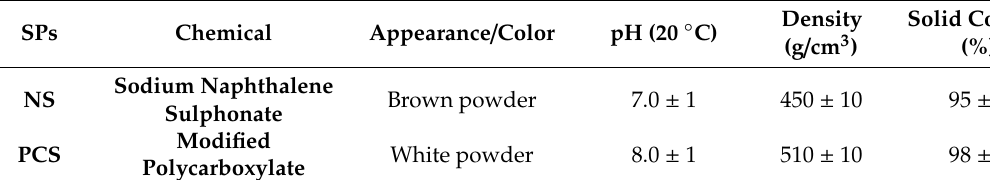
Table 5. Physical and chemical properties of the superplasticizers (SPs).